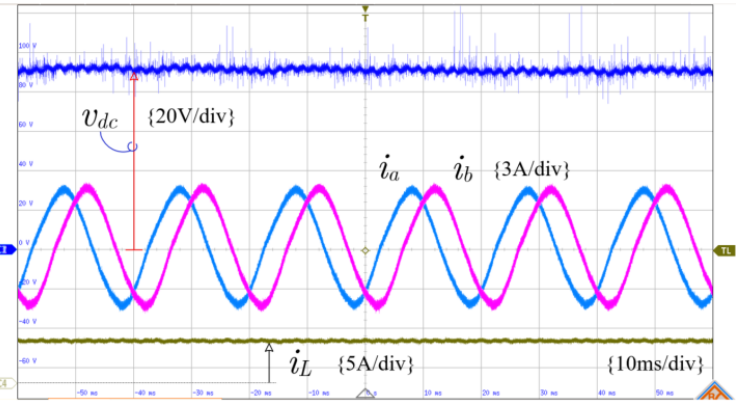
Figure 22. DC-link voltage and input/output current waveforms.